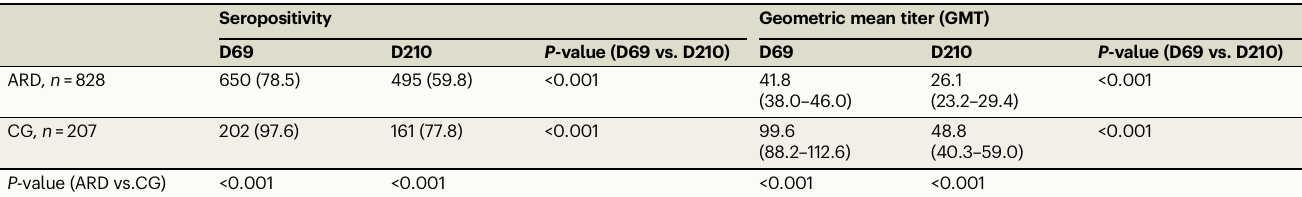
Table 2 | Anti-SARS-CoV-2 S1/S2 IgG seropositivity (SP) rates and titers 6 weeks (D69) and 6 months (D210) after second dose of Sinovac-CoronaVac vaccination in patients with ARD in comparison to CG